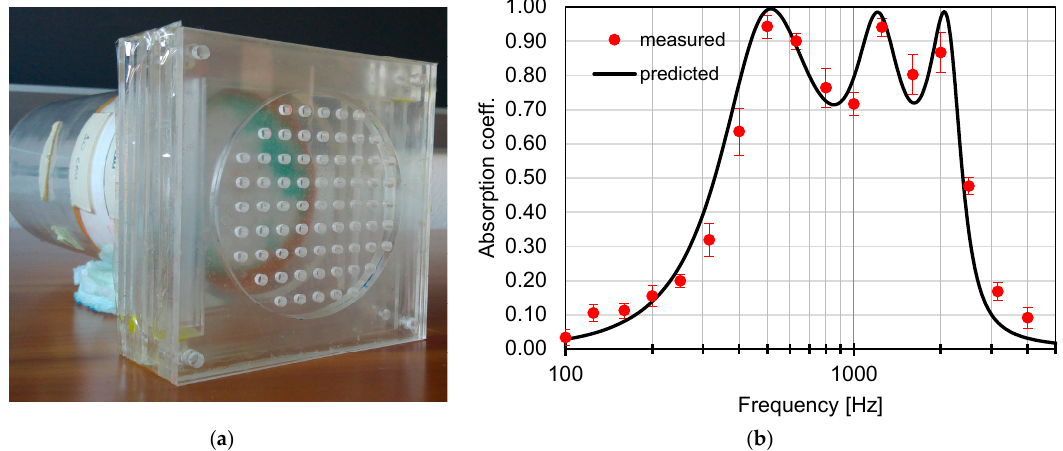
Figure 13. ( a ) The optimized three-layers panel mounted on the sample holder of the standing wave tube. ( b ) Sound absorption coefficient of a triple-leaf resonant absorber, formed by a perforated panel D (with a 20 mm backing cavity, first layer), a micro-perforated membrane with a 4 mm spacing and a 20 mm backing cavity, and a micro-perforated membrane with a 6 mm spacing and a 25 mm backing cavity, close to rigid surface. Error bars represent measured standard deviation.